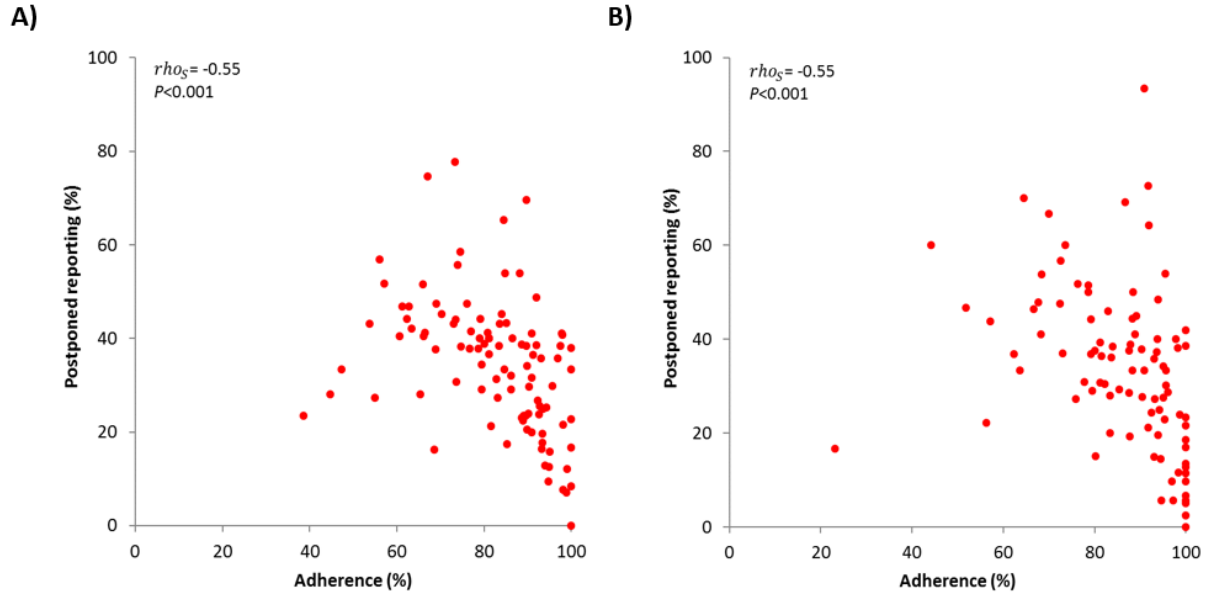
Figure 4. Correlation between postponed reporting (%) and total reporting period adherence (%) by study center: (A) Rome (n=101); (B) Pordenone